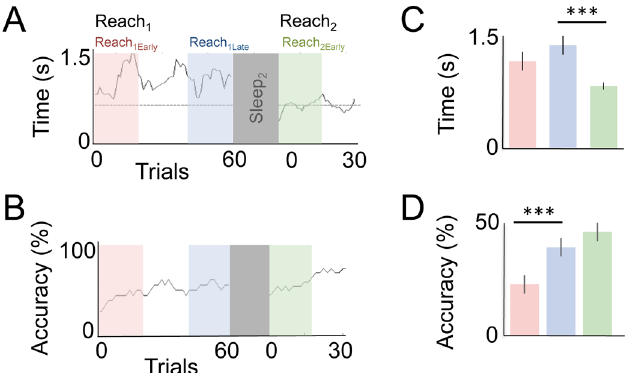
Fig 2. Comparison of online and offline changes in skilled motor behavior. Motor learning was characterized across two major parameters: speed and accuracy. (A) Speed was quantified for every trial by measuring the time from reach onset to retraction of forelimb. (B) Unlike changes in speed, animals showed a general improvement in accuracy across the learning block (Reach 1 ), but accuracy was not significantly different after sleep (Reach 2 ). For both plots we used a moving average window of ten trials. (C,D) Effects were quantified across all animals ( n = 5). Error bars represent mean ± SEM; *** p < 0.001.